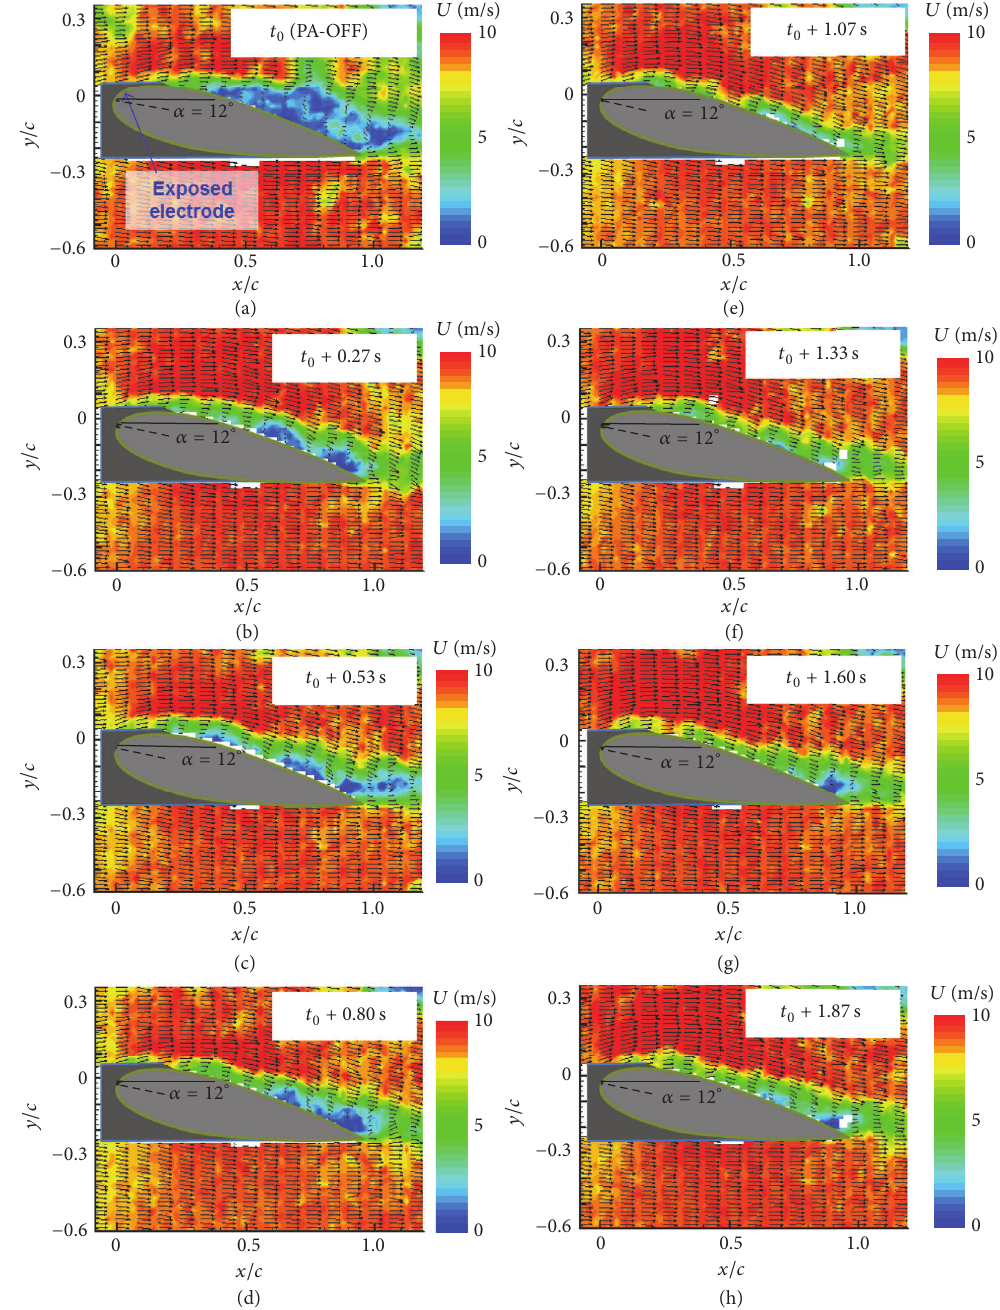
Figure 18: A series of velocity distributions with open-loop control of flow separation measured by PIV ( 1/3.75 ≈ 0.27 s intervals) with periodic wall oscillation. Flows around the NACA0024 hugged the suction surface, with exception of the situation under PA-OFF conditions (a), which is just before